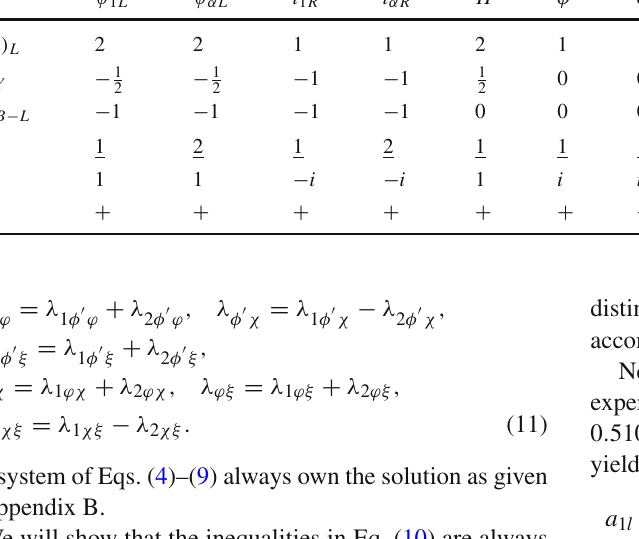
Table 2 The particle contents of the model and their transformations under the chosen symmetries ψ 1